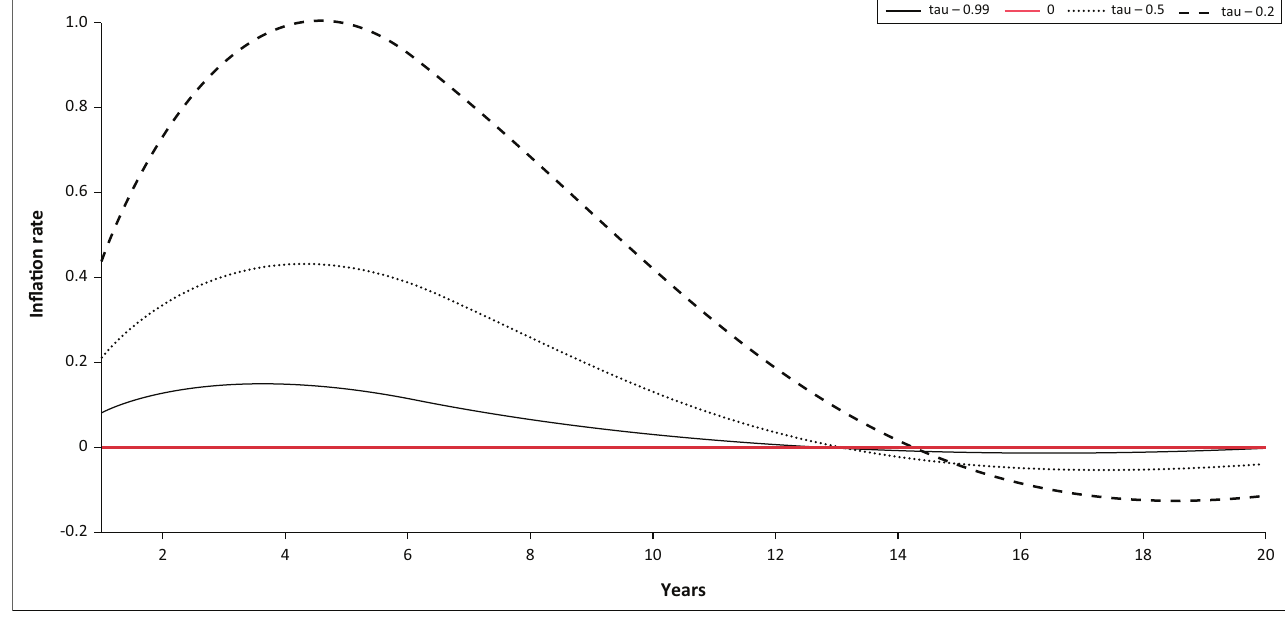
FIG URE 3: Impulse responses of inflation to a positive fiscal policy